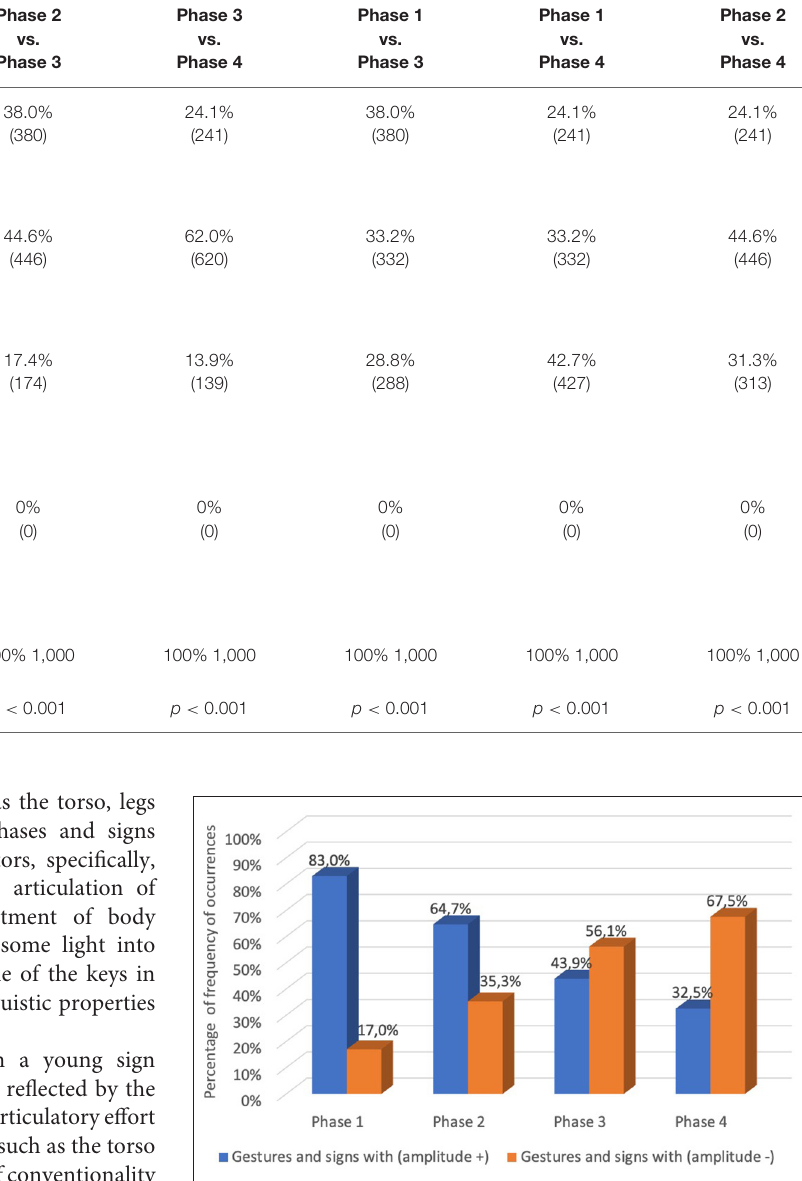
TABLE 5 | McNemar Test: Comparison of pair of phases based on the number of one-handed and two-handed gestures or signs occurrences considering the analyzed 1,000 gestures and